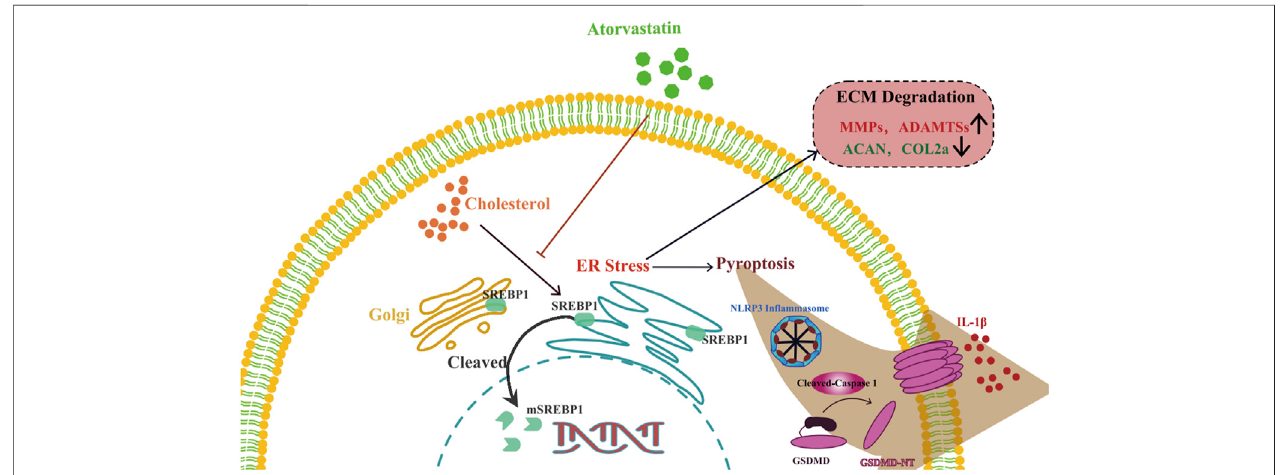
FIGURE 7 | Schematic illustration of the role of cholesterol in the development of IDD. Cholesterol induces pyroptosis of NP cells and ECM degradation by activating endoplasmic reticulum stress through promoting maturation of SREBP1 in the development of IDD.